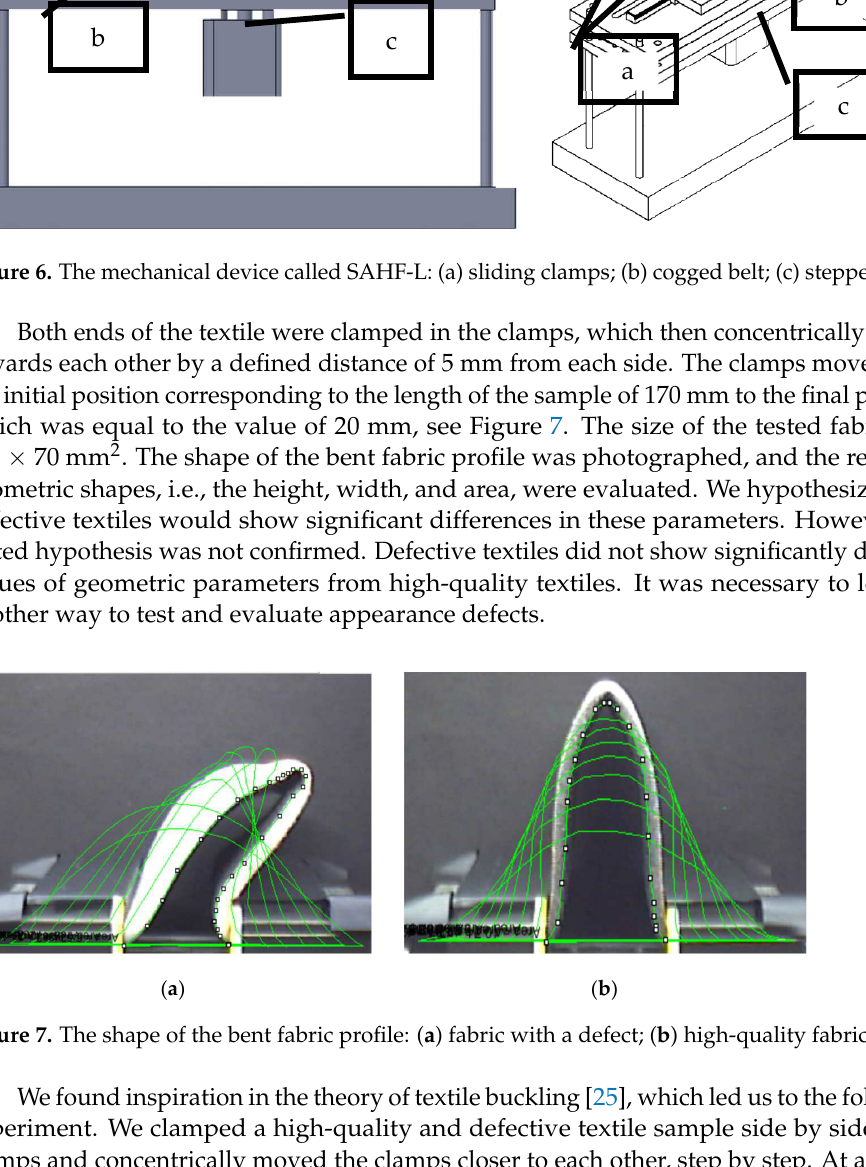
Figure 7. The shape of the bent fabric profile: ( a ) fabric with a defect; ( b ) high-quality fabric.